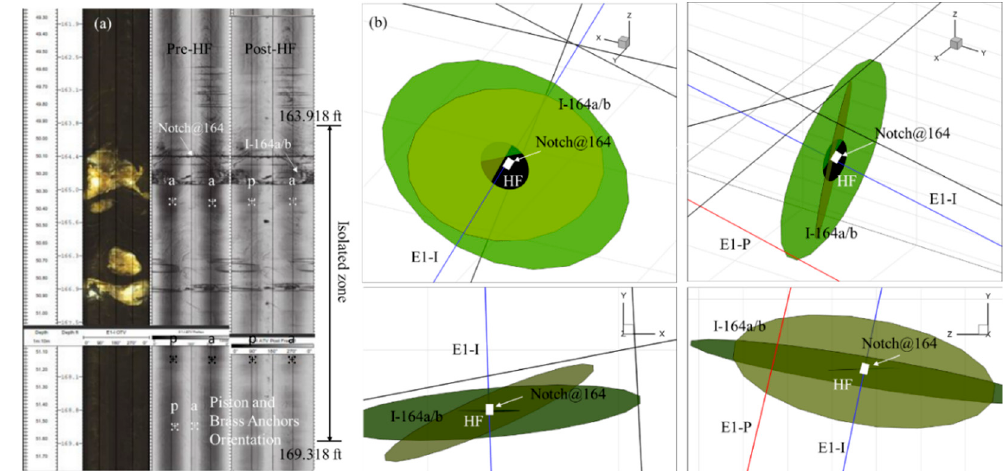
Figure 9. The details of E1-I around the Notch ≅ 164 on May 23, 2018 [2]. ( a ) The location of isolated zone. ( b ) The generation of the hydraulic fracture is assumed to be due to the injection into Notch ≅ 164. Note that the hydraulic fracture almost overlaps with I-164a/b [2].